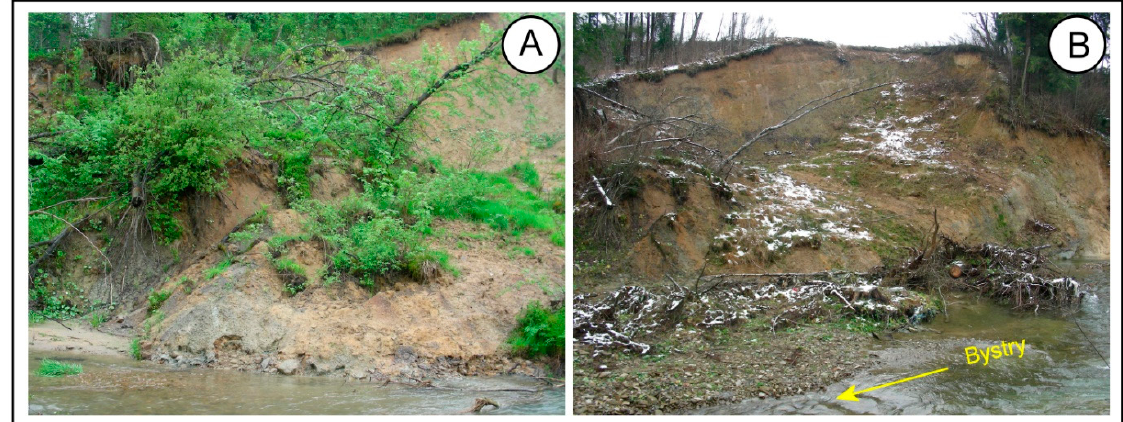
Figure 11. Erosion of colluvium by the Bystry River (3) after water level rises in 2014 ( A ) and in 2018 ( B ).